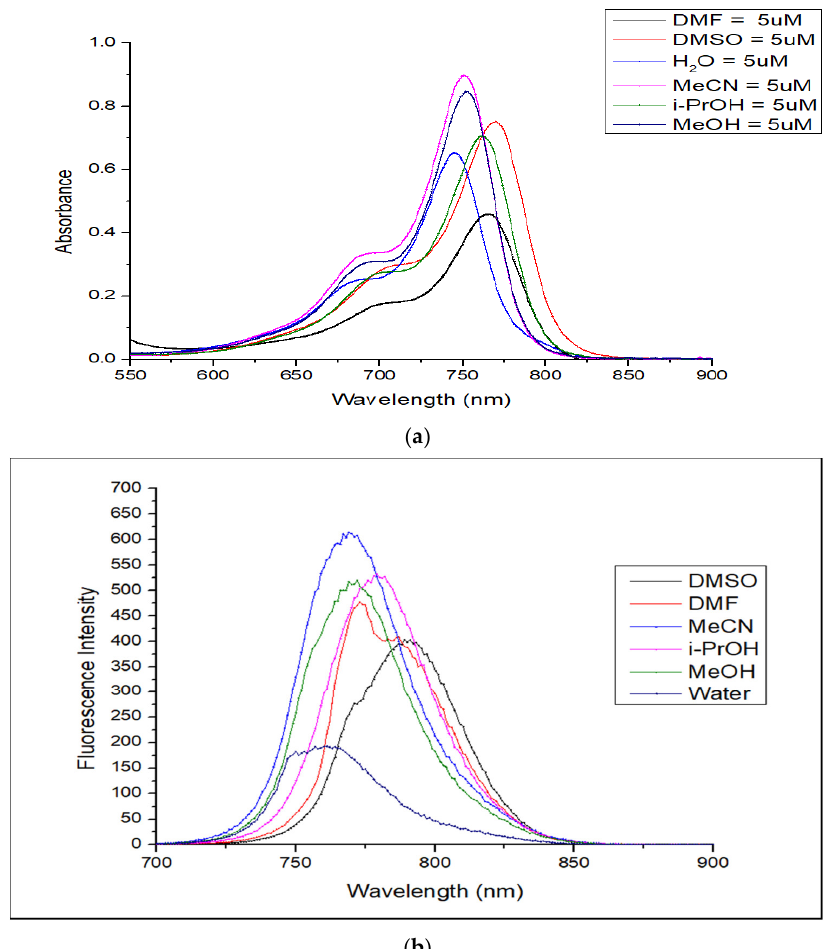
Figure 3. ( a ) Absorbance spectra of ERB-60 (5 uM) in different solvents. ( b ) Fluorescence spectra of ERB-60 in both polar protic and aprotic solvents.